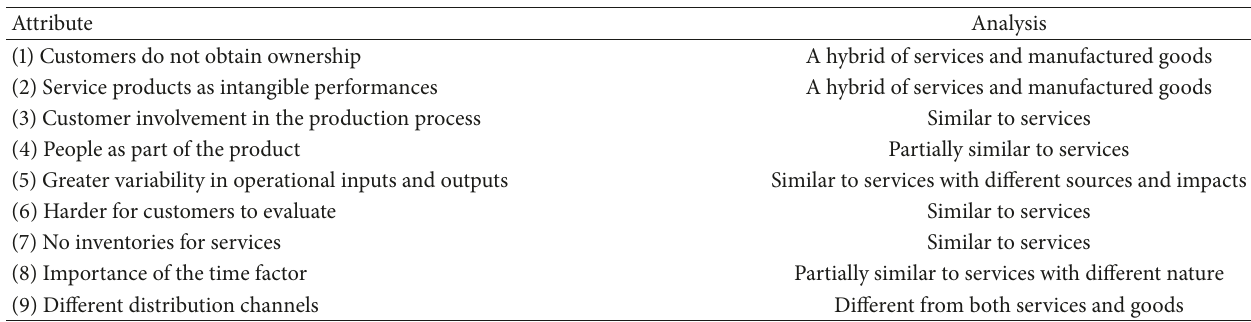
Table 2: Service attributes versus